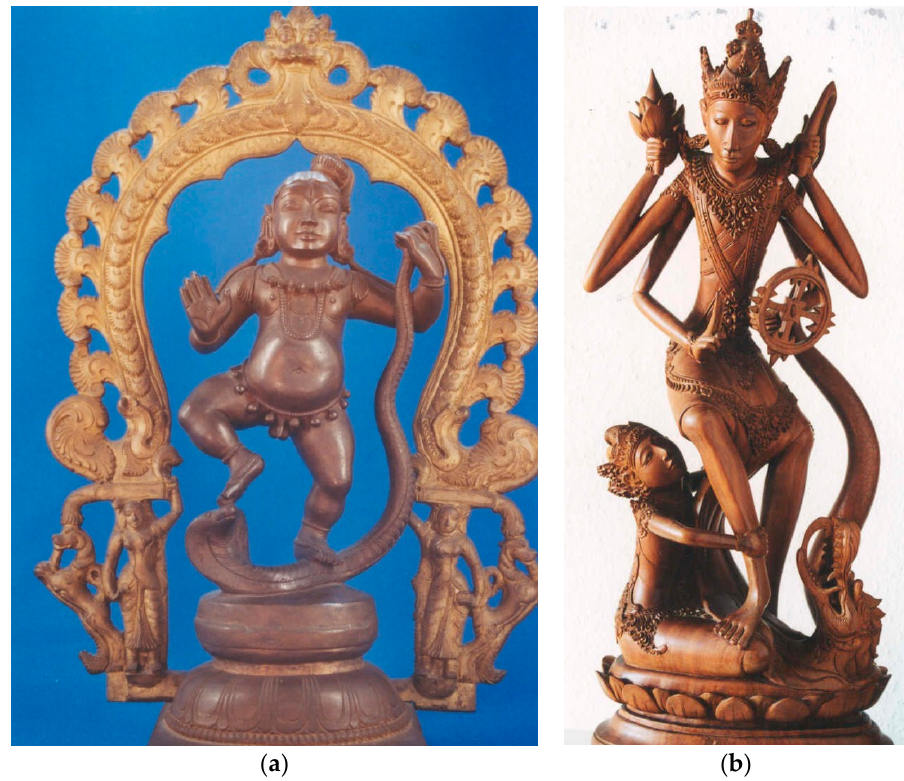
Figure 7. K ṛṣṇ a dances on the subdued N ā ga king K ā liya, who had polluted the Yamun ā River with his poison. Now, as the footmark of K ṛṣṇ a protects him, K ā liy ā and his queens are safe from Garu ḍ a, who, as a devotee of Vi ṣṇ u, also venerates his avat ā r K ṛṣṇ a. ( a ) Metal figure given by Rudolf Otto in 1927 to Marburg Museum of Religions (photo by Eiko Wösner, acc.nr. Lp 139); ( b ) Figure from Bali, purchased 1959 for the Marburg Museum of Religion in Yogyakarta. In Indonesia, N ā gas are depicted as being dragon-like, while K ṛṣṇ a/Vi ṣṇ u can be identified by his four arms, holding a discus and lotus flower. Striking are the similarities in the posture of the legs and the gesture of the left hand, holding the serpent/dragon’s tail (photo by Eiko Wösner, acc.nr. Ar 081).